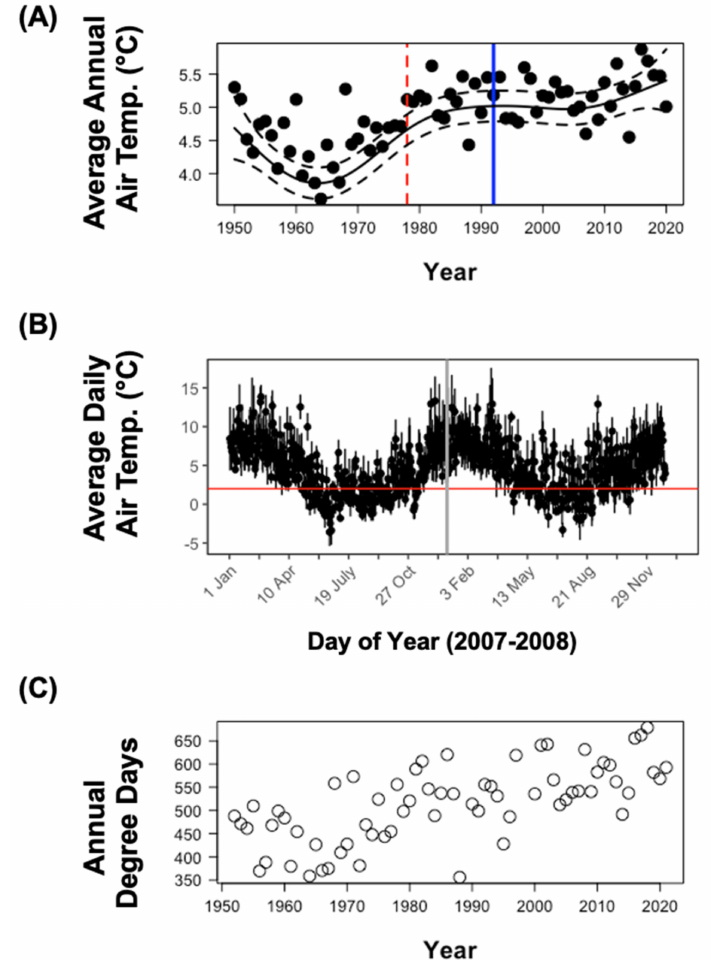
Figure 2. Temperature trends at the Kerguelen Islands and comparison of accumulated degree days with estimated thermal requirements of C. vicina . ( A ) Annual average air temperature from 1950–2020 (the vertical red dashed line indicates when C. vicina was first observed at the archipelago and the blue vertical line indicates when the monitoring of C. vicina was initiated). ( B ) Daily temperature fluctuations across two example years (2007–2008) with vertical grey line indicating the start of the calendar year and the horizontal red line indicating the assumed minimum developmental temperature (2 ◦ C). ( C ) Degree days accumulated by the end of the breeding season calculated from 200th day of year (austral mid-winter when adult flies are inactive) to end of February of following year, based on daily temperatures. Temperature data from M é t é o